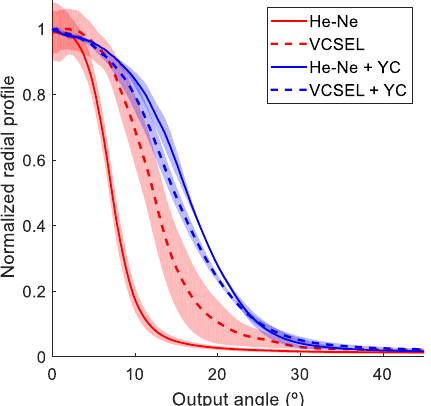
Figure 5. Radial profiles from far-field patterns for two different optical sources at the output of 2 m GH4002 (GH) fiber (red lines) and at the output of the Y-coupler (blue lines).